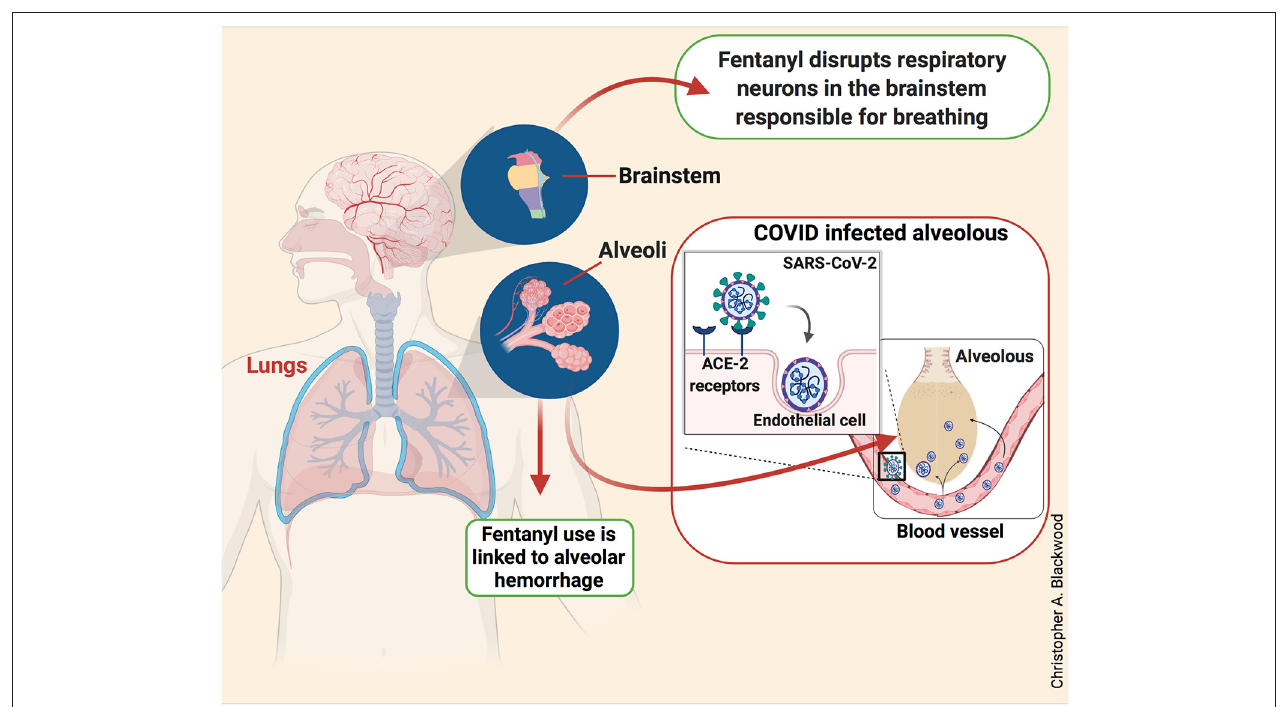
FIGURE 1 | Fentanyl and COVID-19 effects on the respiratory system. Cartoon illustration of a human body showing the negative impacts of fentanyl and SAR-CoV-2 on the respiratory system. Fentanyl disrupts neurons responsible for breathing and causes alveolar hemorrhage in the brainstem and lungs, respectively (green boxes). This illustration also shows how SARS-CoV-2 enters the vascular system through ACE-2 receptors expressed on endothelial cells. The entry of SARS-CoV-2 through endothelial cells is, in part, responsible for the severe acute respiratory syndrome (red